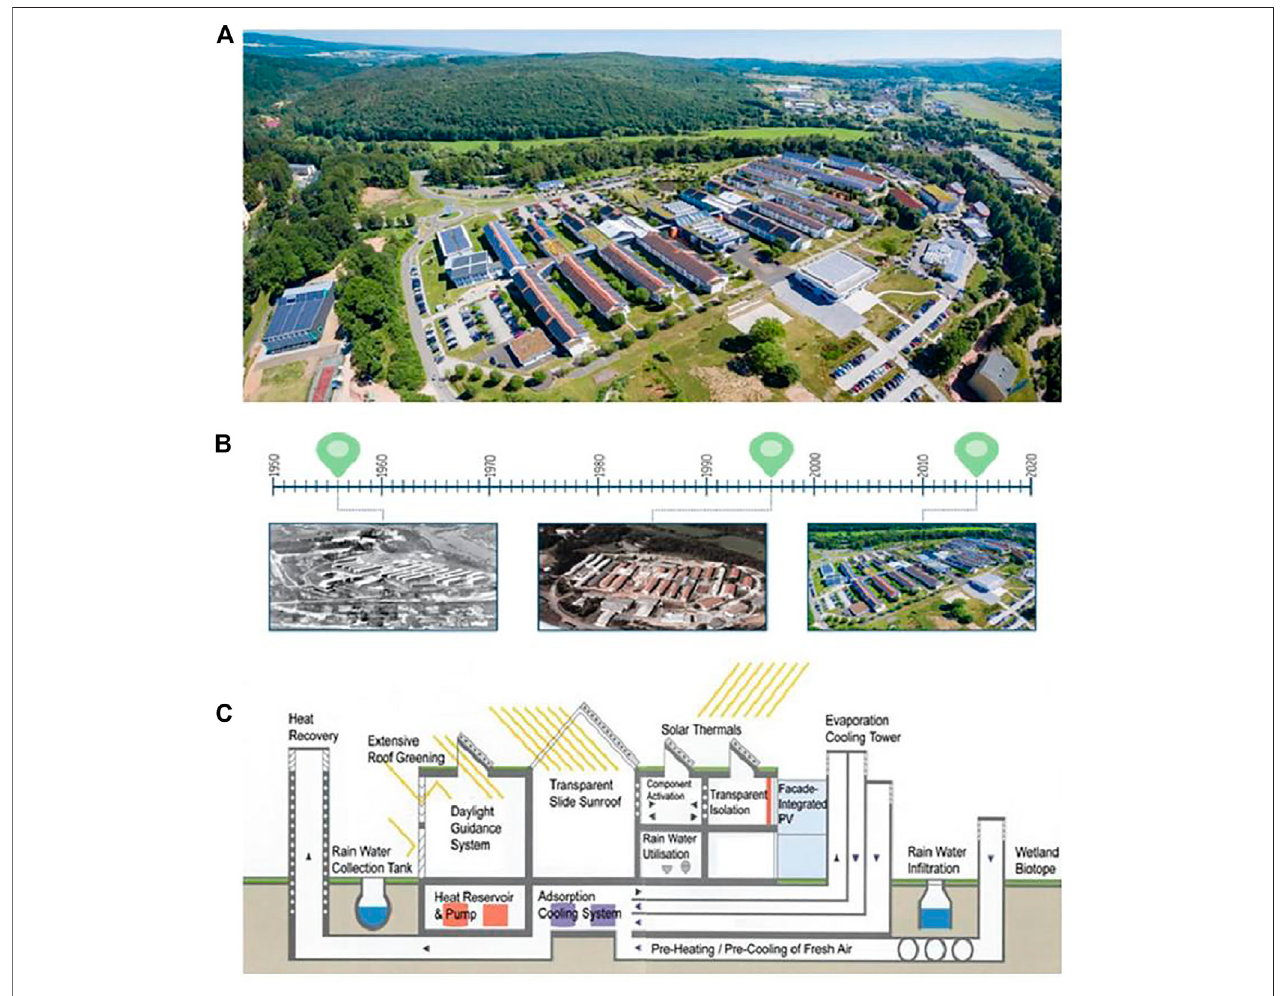
FIGURE 7 | Zero-emission campus as a living lab the systemic approach (Heck et al., 2021).